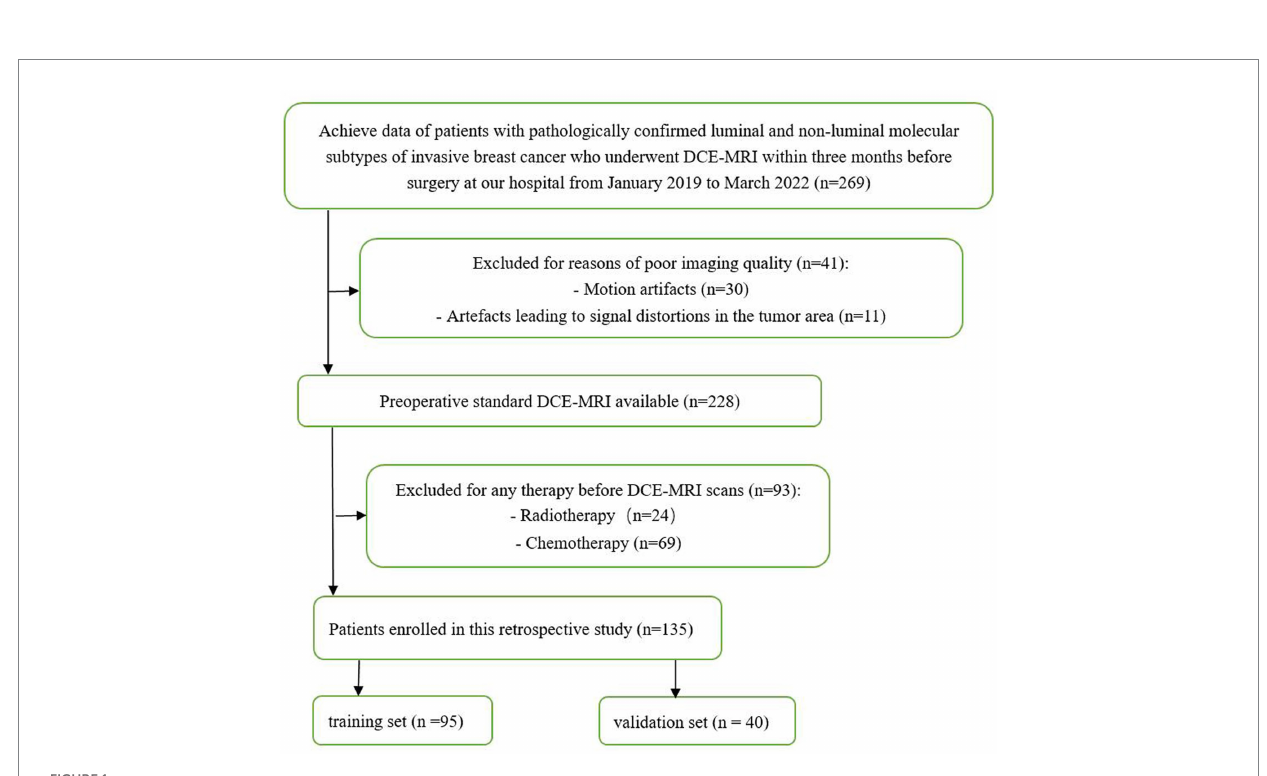
FIGURE 1 Flow diagram of the study.